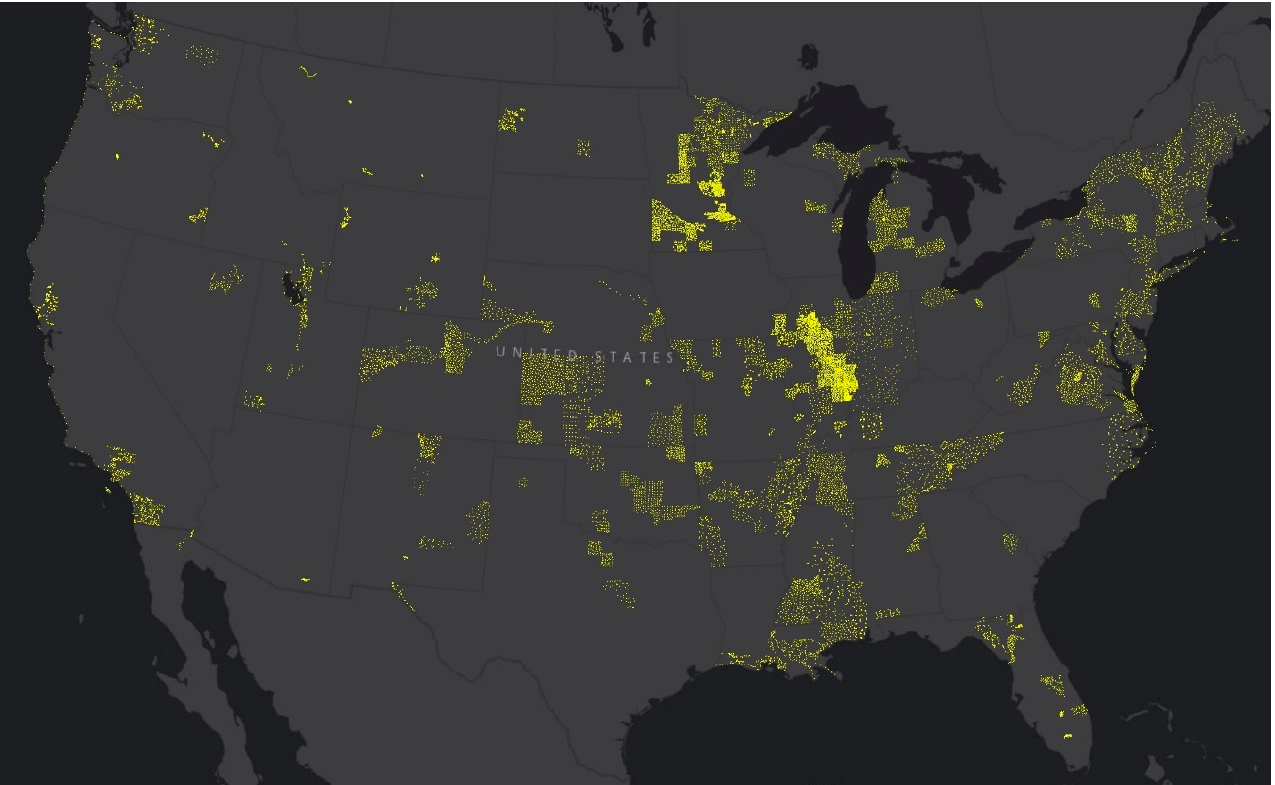
Figure 3. Locations of 3DEP lidar checkpoints ( n = 50,486).